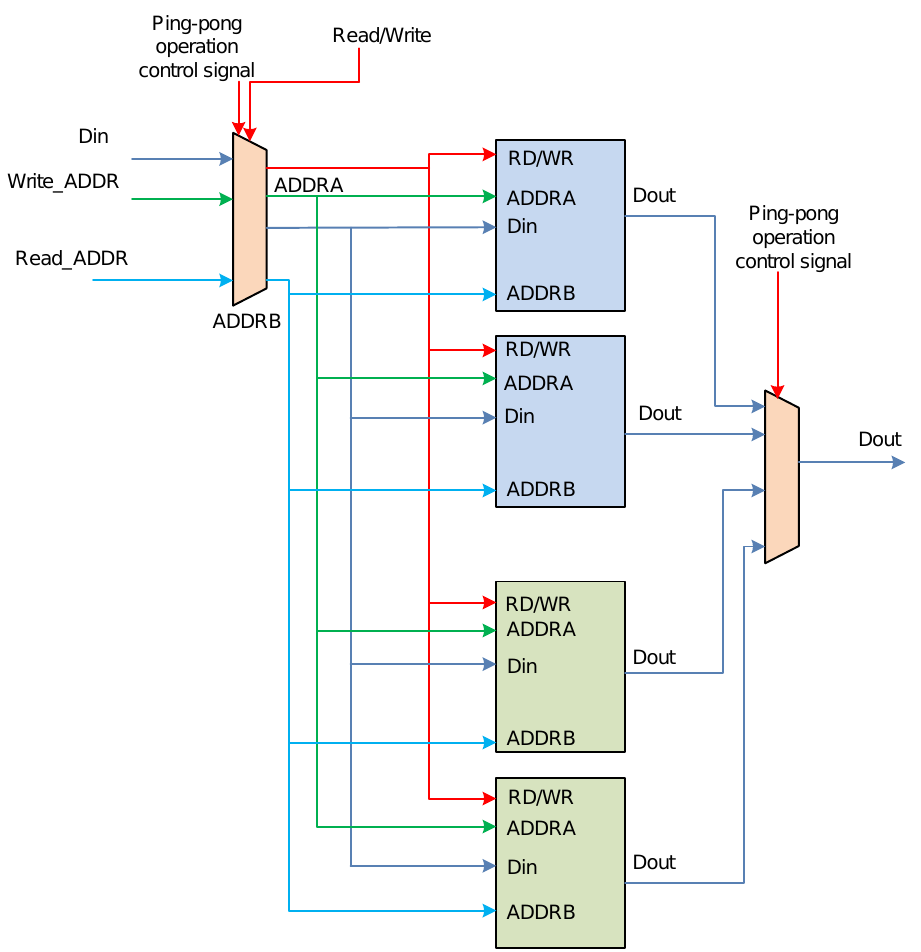
Figure 7. Structural diagram of the double